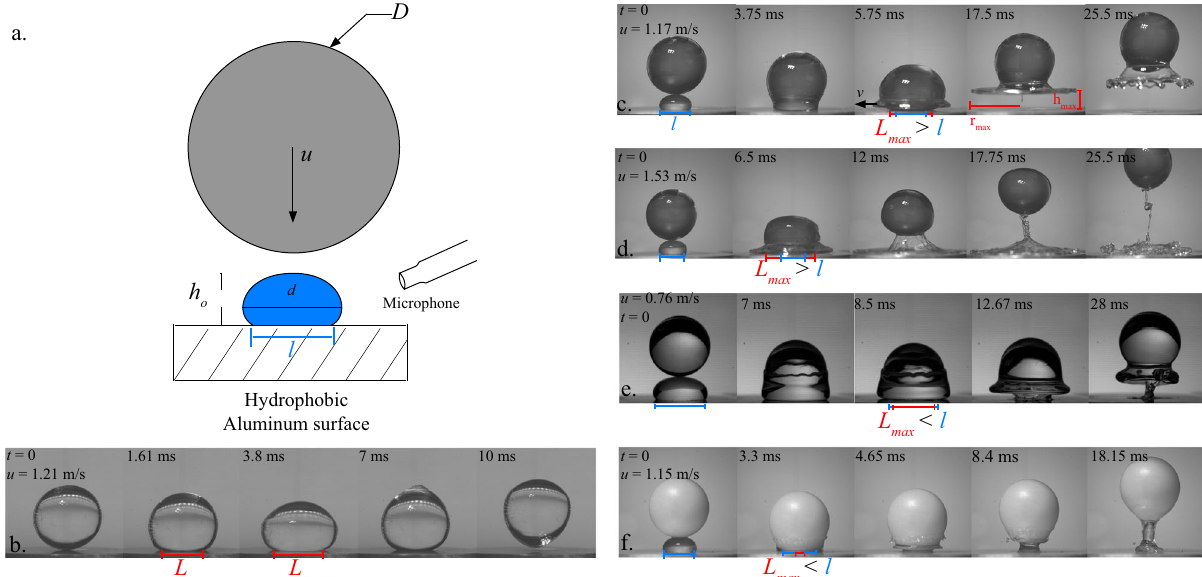
Fig. 1 Experimental setup and sphere-droplet impact dynamics. a Schematic of the experiment: a soft hydrogel sphere (diameter D ) impacts a droplet resting on a hydrophobic aluminum substrate (contact angle θ c (cid:1) 141 (cid:4) ). The droplet takes on a fl attened shape on the surface resembling a large puddle with a maximum height of h o ¼ 2 κ (cid:3) 1 sin ð θ c = 2 Þ . The length of the droplet base is l (blue bars, l < d where d is the maximum azimuthal diameter of the droplet). A microphone captures the acoustic signature of the impact event. b On impact, the hydrogel sphere ( D = 16 mm) deforms, with the sphere base length ( L , red bars) increasing over time ( t = 0 – 3.8 ms) and reaching a maximum value and then retracting to rebound off the surface. c If L surpasses l when the hydrogel sphere impacts a resting droplet, the droplet simultaneously spreads radially ( t = 0 – 5.75 ms) and lifts off vertically during this spreading leaving no water remnant on the surface. h max is measured at r max for consistency, even though the droplet continues to rise higher ( t = 25.5 ms). d Impact velocity of the hydrogel sphere plays an important role in determining whether the droplet would lift-off, as greater impact velocity results in dominant radial spreading and suppression of the droplet rebound. e If maximum deformed base length of the hydrogel sphere ( L max ) is less than l ( t = 8.5 ms), the droplet fails to completely lift-off on sphere-impact, leaving a water puddle on the surface which connects to the rebounding hydrogel sphere in the form of a water column ( t = 8.5 – 28 ms). f This behavior is similar to the impact of a rigid sphere ( D = 16 mm) on a droplet. Here also, we observe L max < l similar to no lift-of case in ( e ). The droplet does not completely separate from the substrate in this case either, indicating that deformation of the soft sphere is essential to droplet lift-off. Supplementary movies 1 – 5 show these impact events in their